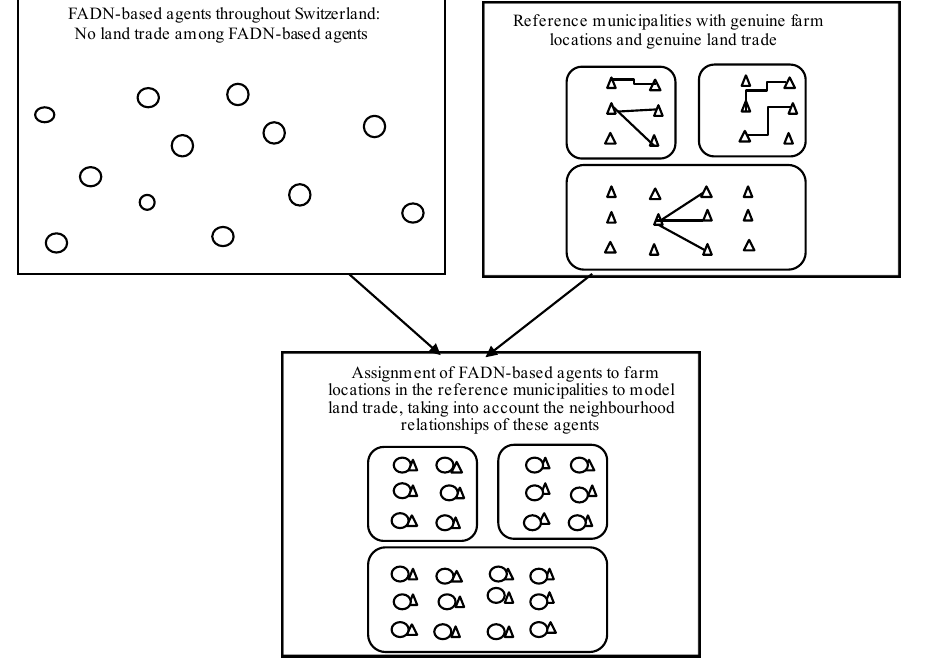
Figure 2. Assignment of FADN-based agents to farms in reference municipalities to model land